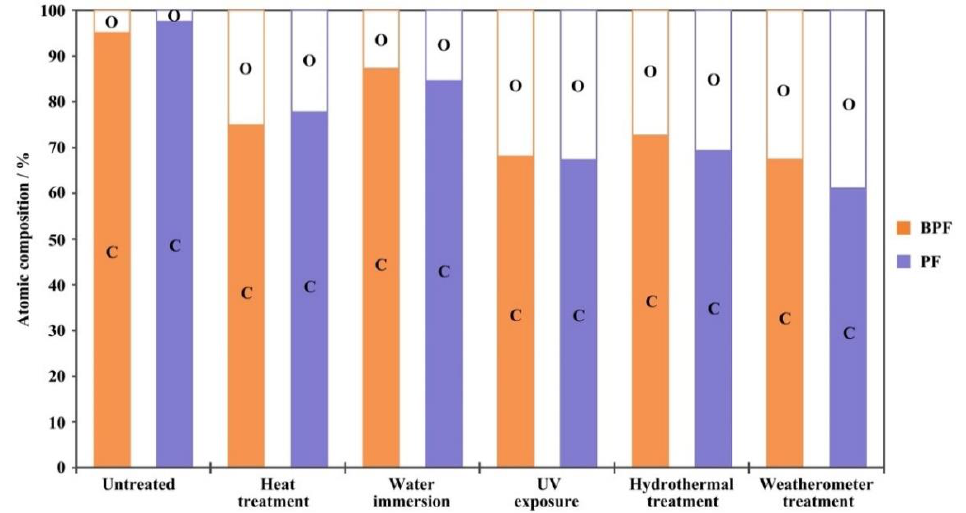
Figure 4. XPS surface atomic composition of BPF and PF resin films under five aging conditions for 960 h. 960